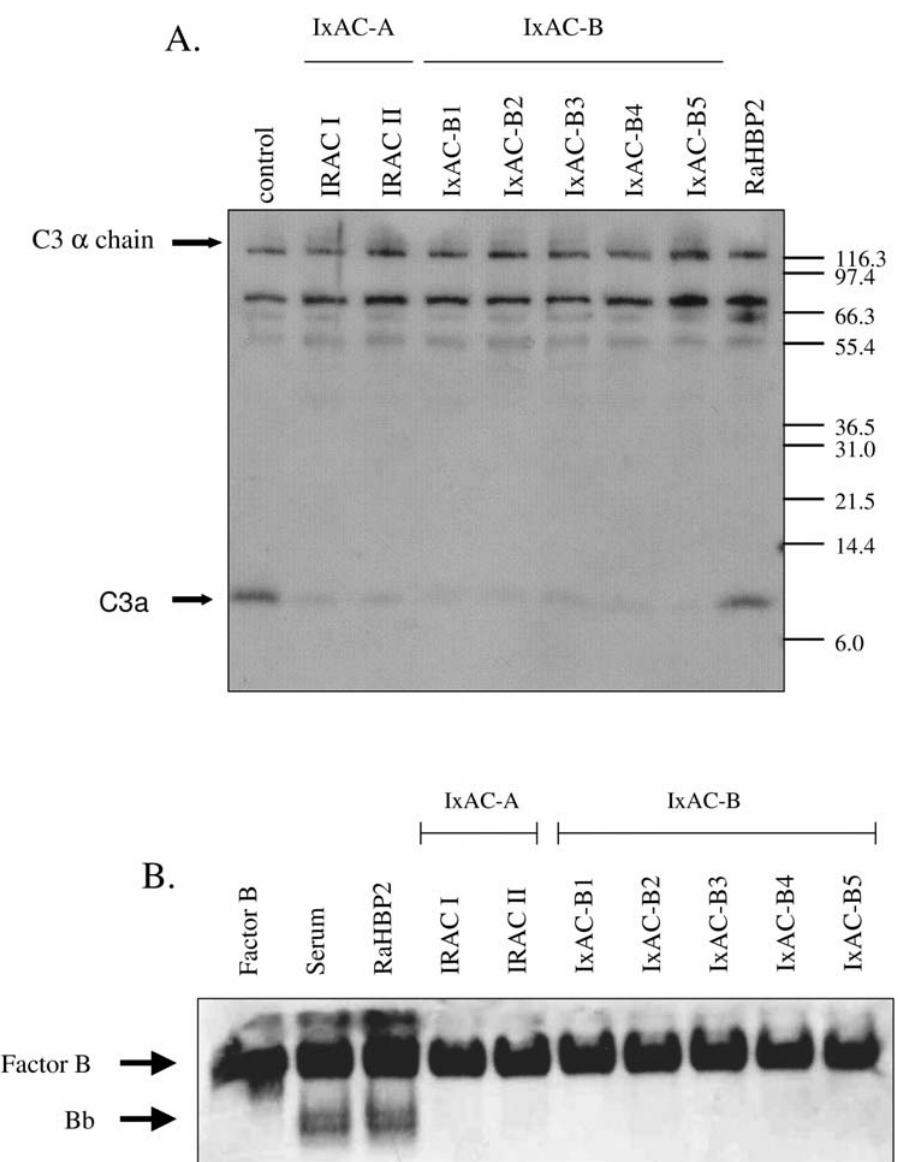
Figure 6. Inhibition of C3a formation and factor B cleavage. Aliquots of supernatant from AP hemolysis assays conducted in the presence of standardized amounts of IxACs from I. ricinus and unrelated control RaHBP2 were analyzed by western blotting. Panel A: Blots from gels run under denaturing conditions were probed with monospecific anti-C3a serum. The a -chain of precursor C3 (116 kDa) and the C3a peptide ( , 10 kDa) are indicated by arrows. Panel B: Blots from gels run under non-denaturing conditions were probed with a antiserum to factor B. Purified factor B was used as a positive control.